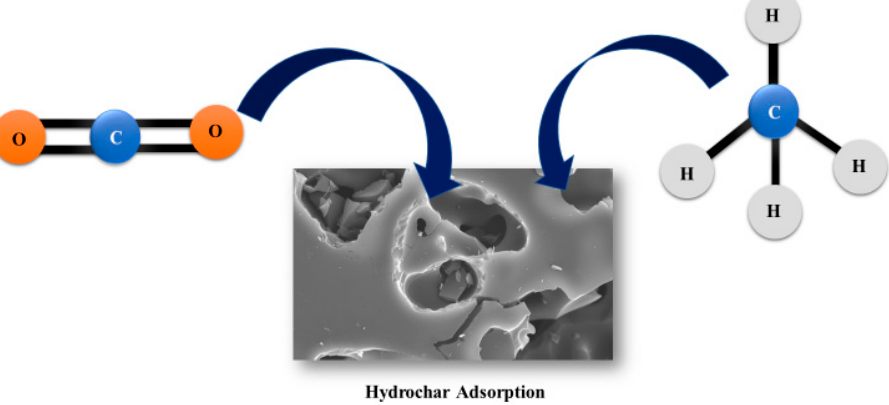
Figure 3. Greenhouse gas adsorption by porous